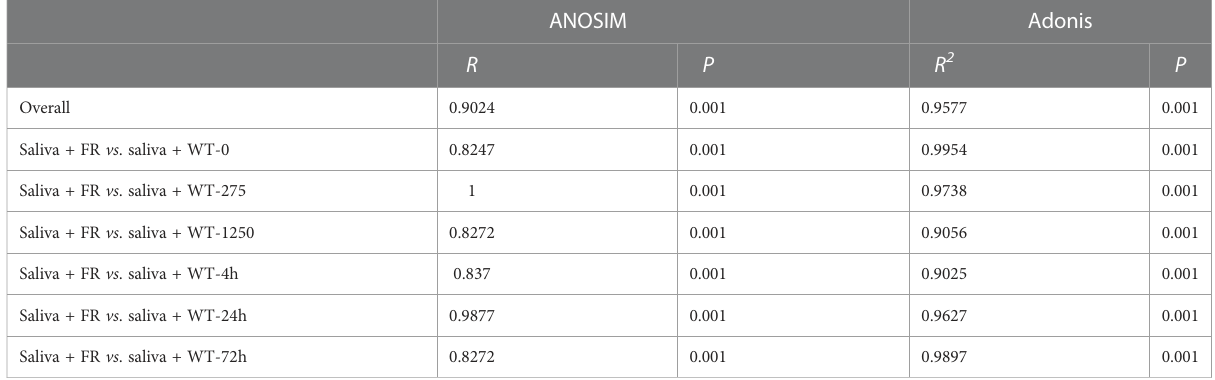
TABLE 1 Dissimilarity tests (Adonis and ANOSIM) for the bio fi lm